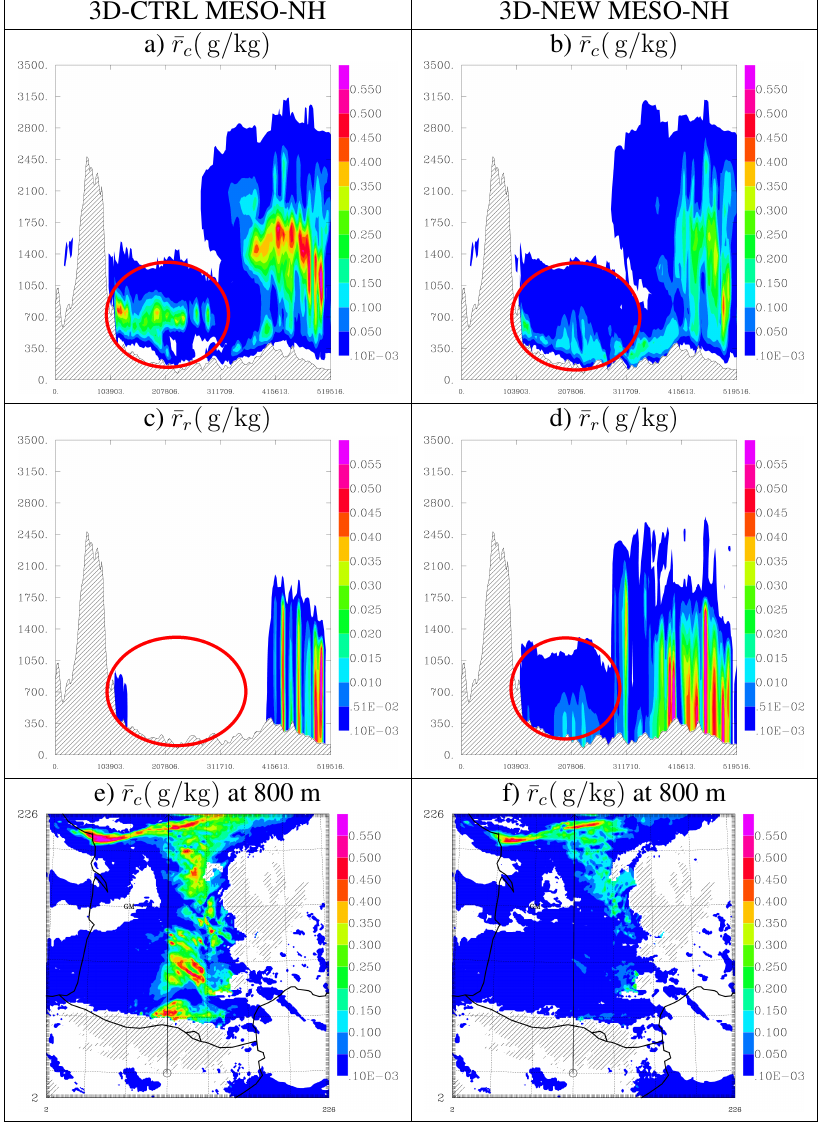
Figure 16: Cross section of ¯ r c (a and b) and ¯ r r (c and d) for Meso-NH runs 3D-CTRL (left) and 3D-NEW Fig. 16. Cross section of ¯ r c ( a and b ) and ¯ r r ( c and d ) for Meso-NH runs 3-D-CTRL (left) and 3-D-NEW (right). ( e and f ) Mean cloud water (right). (e and f) Mean cloud water content at 800 m for 06 UTC March 27, 2009, with the cross section content at 800m for 06:00 UTC, 27 March 2009 with the cross section indicated by the black indicated by the black line.